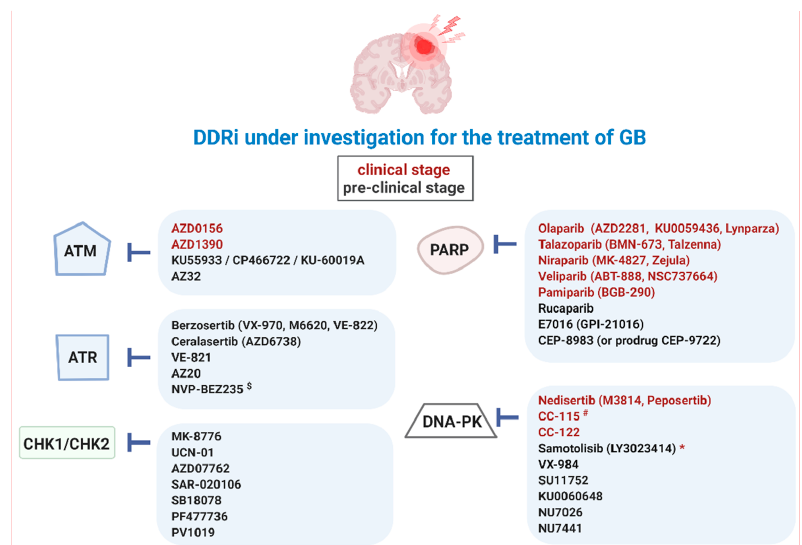
Figure 3. Overview of DDRi for targeted therapy of GB. Ataxia-telangiectasia mutated (ATM), ATM-RAD3-related protein (ATR), checkpoint kinase-1 and -2 (CHK1/2), DDR kinase inhibitor (DDRi), DNA-dependent protein kinase (DNA-PK), poly (ADP-ribose) polymerase-1 and -2 (PARP). $ also targets phosphatidylinositol-3-kinase (PI3K)/Akt and the mammalian target of rapamycin (mTOR) signaling pathways (PI3K/mTOR), * paediatric central nervous system tumors, # also targets mTOR.